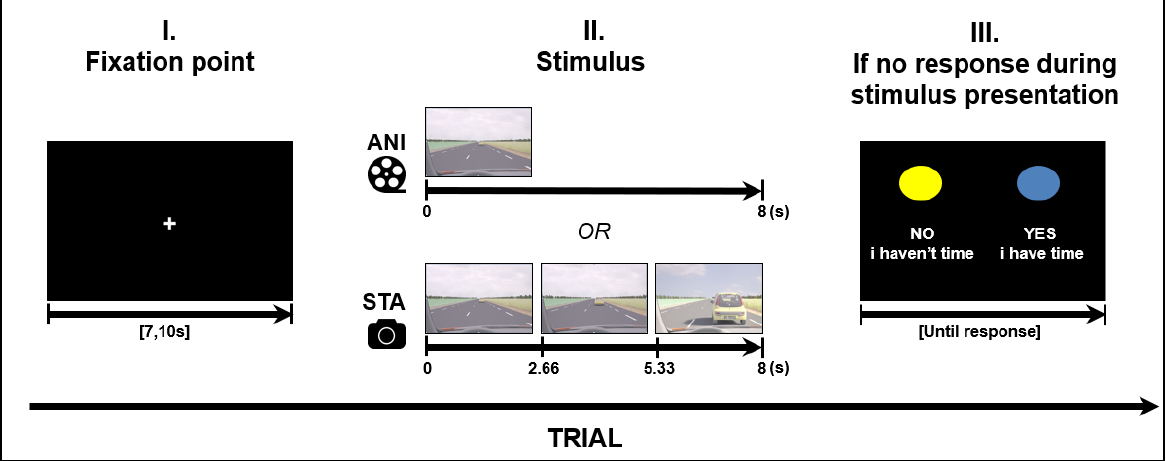
Figure 1. Structure of a trial (road scene presentation), ANI: animated format; STA: sequence of static images.